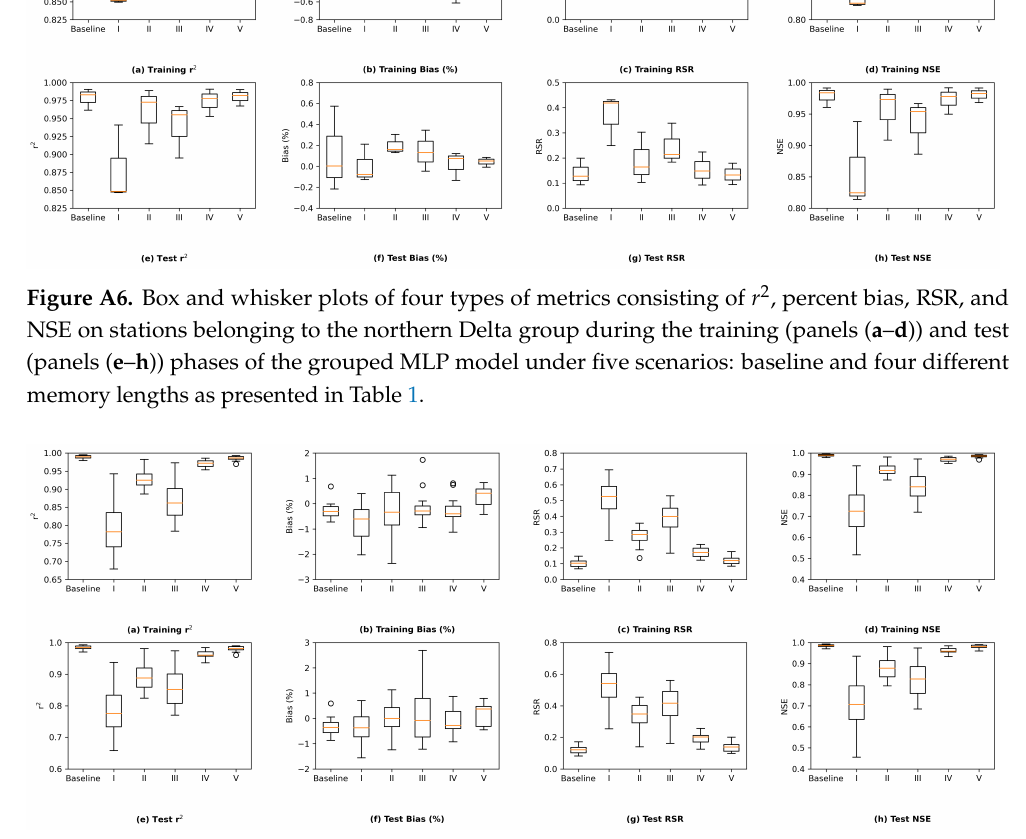
Figure A7. Box and whisker plots of four types of metrics consisting of r 2 , percent bias, RSR, and NSE on stations belonging to the interior Delta group during the training (panels ( a – d )) and test (panels ( e – h )) phases of the grouped (G) MLP model under five scenarios: baseline and four different memory lengths as presented in Table 1.